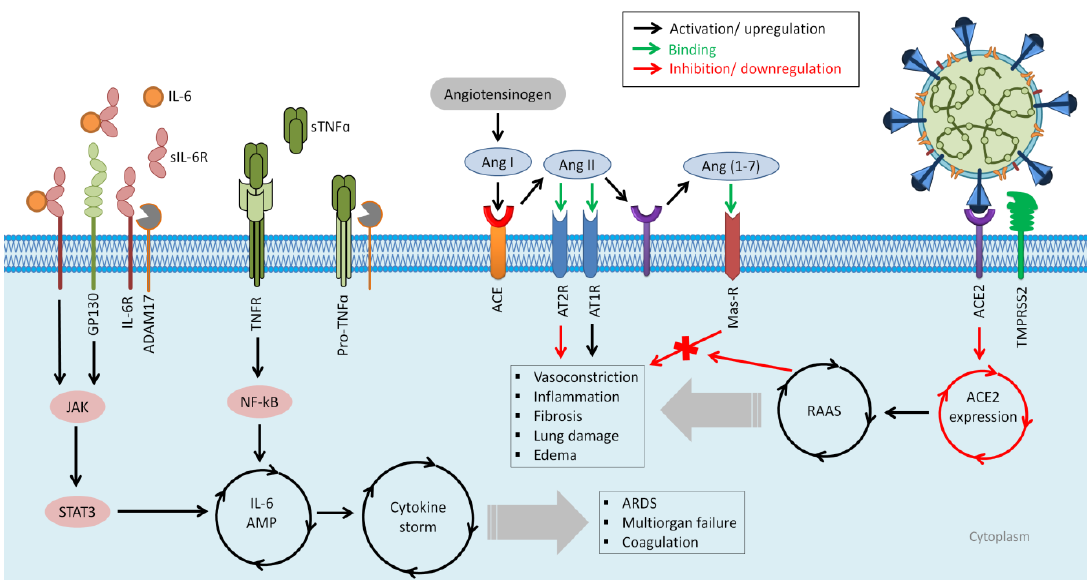
Figure 2. Scheme of possible targets for developing therapeutics against COVID-19 and the presented cytokine release syndrome (CRS). SARS-CoV-2 utilizes ACE2 and TMPRSS2 as cell entry receptors. As a result of SARS-CoV-2 infection, the renin–angiotensin system (RAAS) is overactive. Angiotensin-converting enzyme (ACE) converts angiotensin I (Ang I) to angiotensin II (Ang II) under physiological circumstances, resulting in increased vasoconstriction, inflammation, fibrosis, lung injury, and edema. Ang I is inactivated by angiotensin-converting enzyme 2 (ACE 2), which produces angiotensin 1–7 (Ang 1–7), which interacts with the G-protein-coupled receptor Mas. Because it antagonizes the effects of Ang I, this interaction is thought to be vasoprotective. SARS-CoV-2, on the other hand, decreases ACE2 expression, resulting in RAAS overactivation and increased lung injury and edema. Through angiotensin receptor type 1 (AT1R), AngII functions as a vasoconstrictor and a pro-inflammatory cytokine. AT1R can promote fibrosis, inflammation, acute lung injury, and collagenase activity decrease. Instead, AT2R stimulation protects against renin–angiotensin system (RAS) activation by eliciting anti-inflammatory, antioxidant, anti-fibrotic effects, reduction in vascular permeability, and edema. The hyper-activation of the NF-κB transcription factor by SARS-CoV-2 through pattern recognition receptors (PPRs) causes cytokine-related syndrome (ARDS). Angiotensin 2 (AngII) elevates in the serum because SARS-CoV-2 occupies ACE2 molecules, which, in turn, reduces Ang II breakdown. The inflammatory cytokines, including TNF α and IL-6-soluble (s)IL-6R, are activated by the accumulated AngII via disintegrin and metalloprotease 17 (ADAM17), and the IL-6 amplifier (IL-6 AMP) is subsequently activated, which explains the magnified NF- κ B activation by the co-activation of NF- κ B and STAT3 transcription factors. In a variety of IL-6Ra-negative nonimmune cells, including fibroblasts, endothelial cells, and epithelial cells, ADAM17 stimulation also changes the membrane form of IL-6Ra to the soluble form (sIL-6Ra), followed by the gp130-mediated activation of STAT3 via the sIL-6Ra–IL-6 complex. As a result, the simultaneous inflammatory cascades of NF- κ B and STAT3-mediated signaling further enhance the NF-B activity and form an inflammatory circuit, the IL-6 AMP, which defines an IL-6-based positive feedback loop for inflammation. As a result, the cytokine storm generated by NF-B hyperactivation in IL-6 AMP might result in lethal symptoms such ARDS, severe pneumonia, multiorgan failure, and coagulation. The underlined molecules indicate possible therapeutic targets for cytokine release syndrome